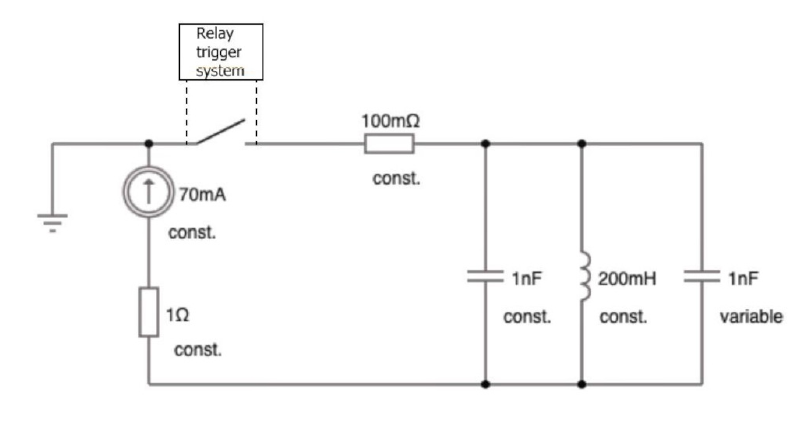
Figure 2. Electrical circuit of the stand.